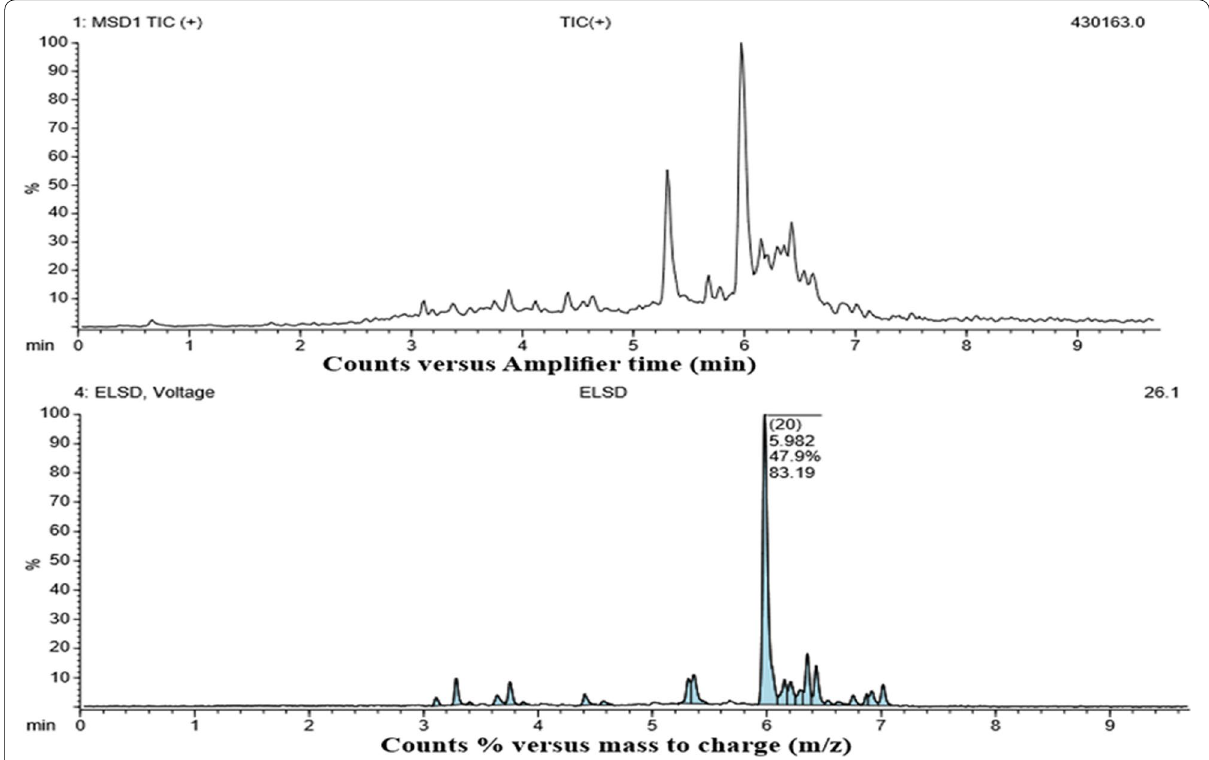
Fig. 4 Total ion current (TIC) and extracted ion chromatograms of acetyl-11-keto-beta-boswellic acid